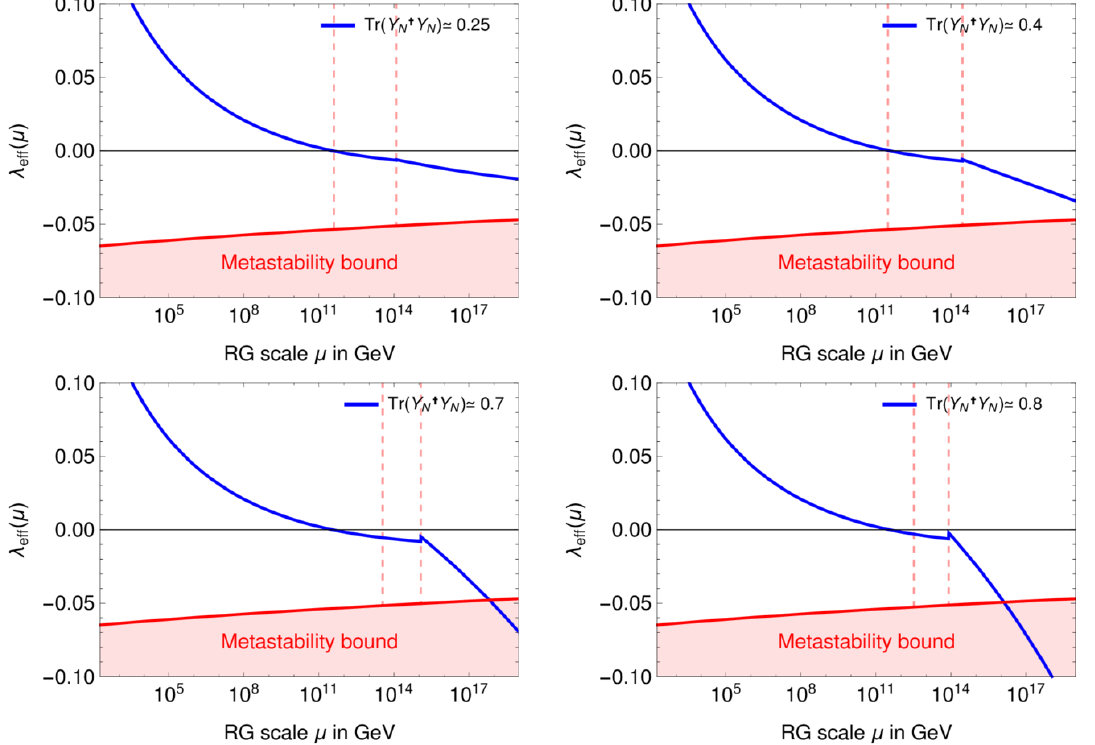
Figure 3 . RG running of the e(cid:11)ective Higgs quartic coupling as a function of the RG scale for points that lead to successful leptogenesis in the type-I seesaw mechanism. The red shaded region corresponds to the region where the lifetime of the EW vacuum is smaller than the age of the Universe. The dashed vertical lines correspond to the masses of N 1 and N 2 . We show the running for di(cid:11)erent values of Tr[ Y y Y N ] at the seesaw N